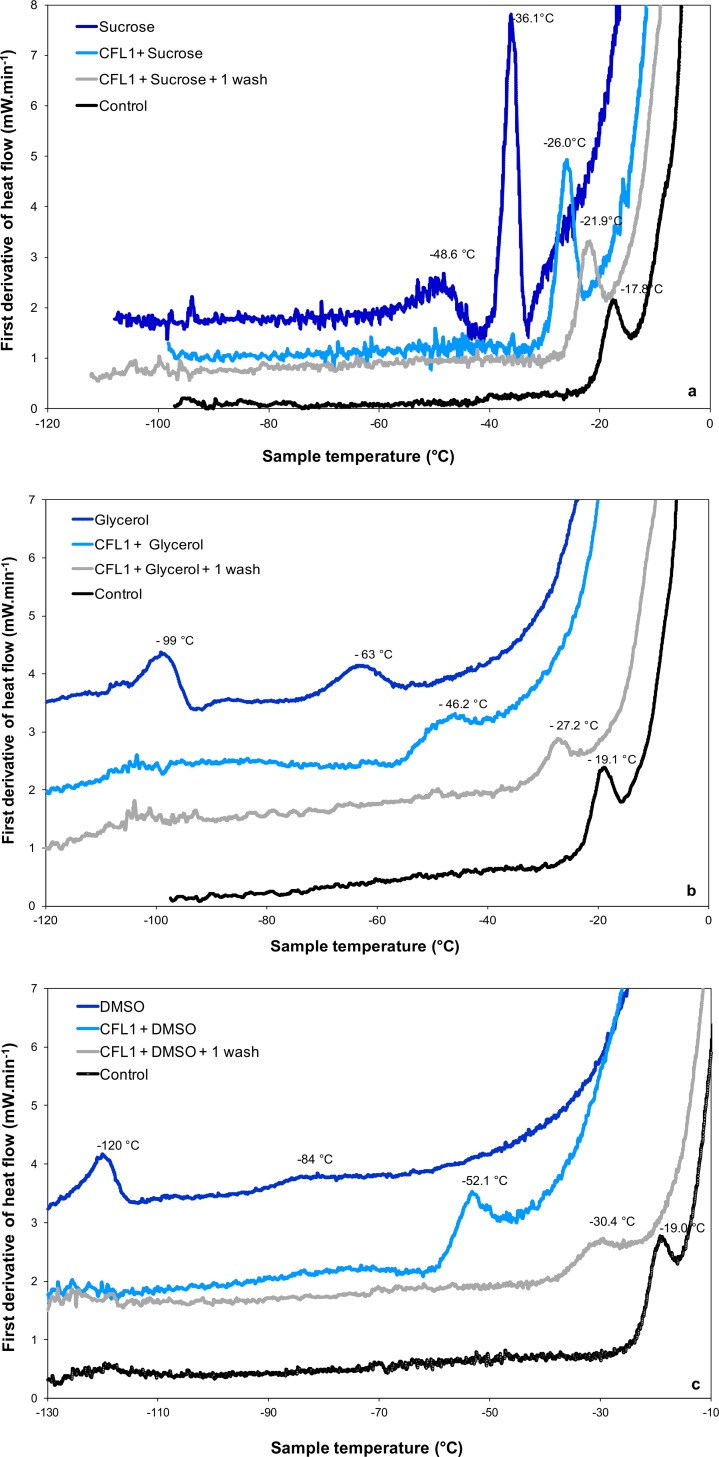
DSC first derivative of heat flow of L. bulgaricus CFL1 with cryoprotective additives and aqueous solutions of cryoprotectants.(a) sucrose, (b) glycerol and (c) DMSO are all additives at 0.58 M. The vitrification temperatures of incubated (light blue curve) and subsequently washed cells (grey curve) are indicated. Samples were cooled below −90°C and then warmed at 10°C.min-1. Control samples (washed with peptone water) (black curves) and aqueous solutions of cryoprotectants (dark blue curves) are also presented for comparison.